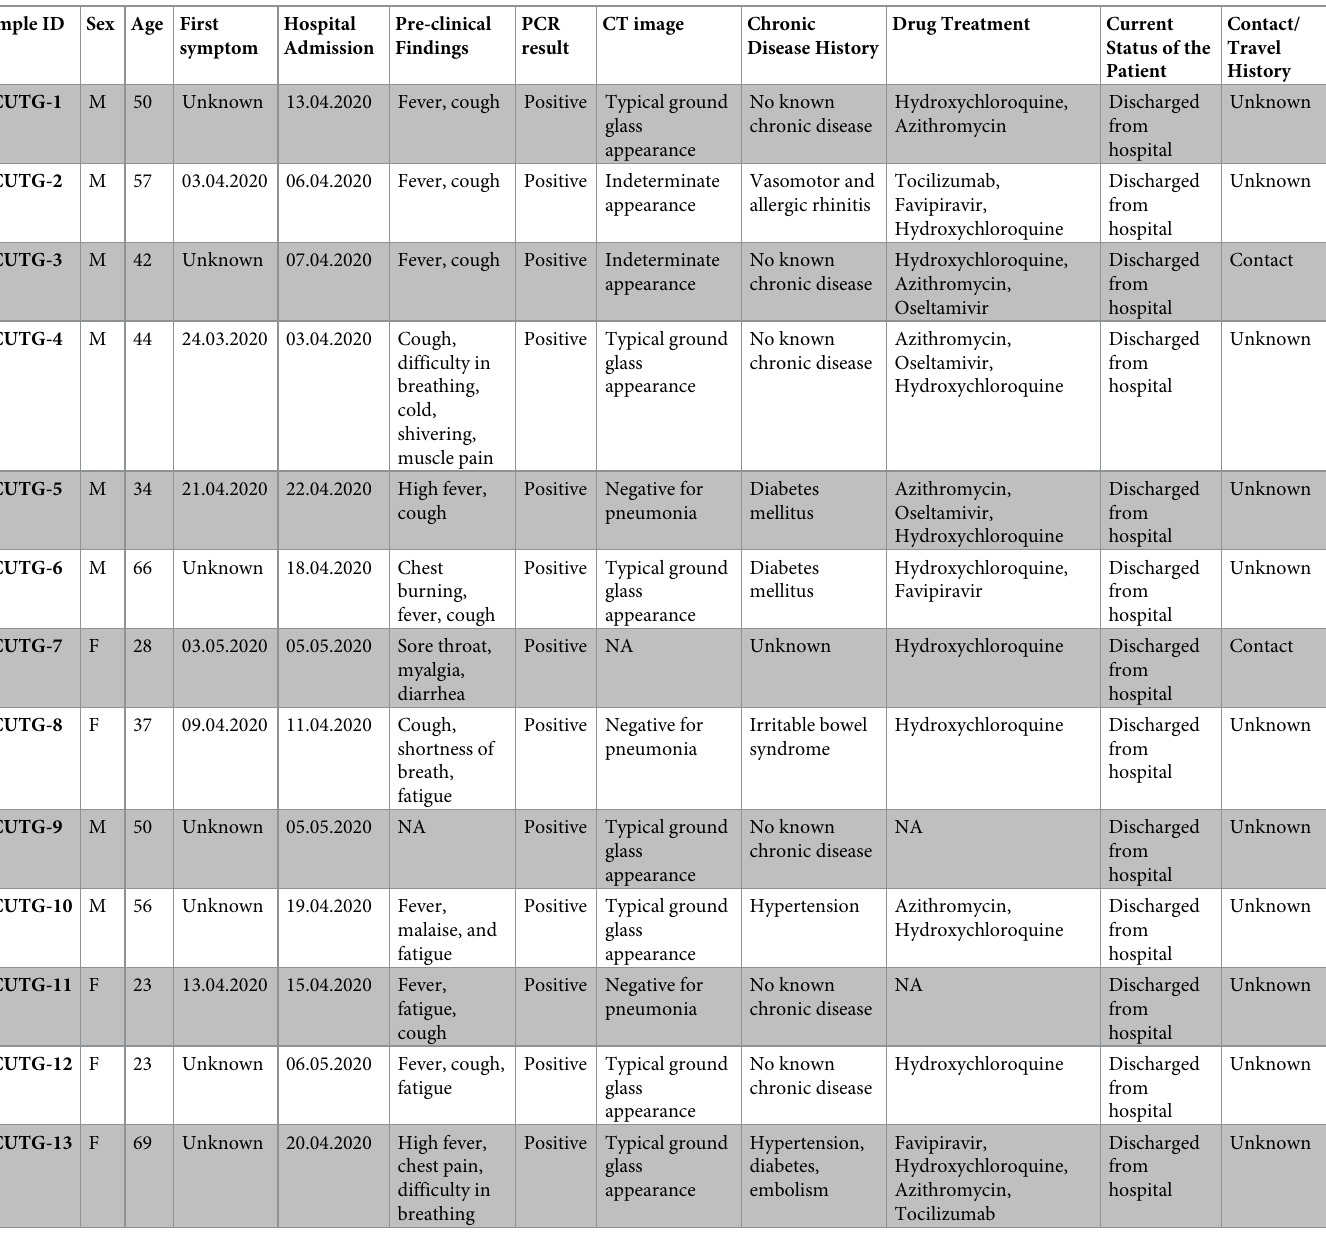
Table 1. Clinical features of patients included in this study.